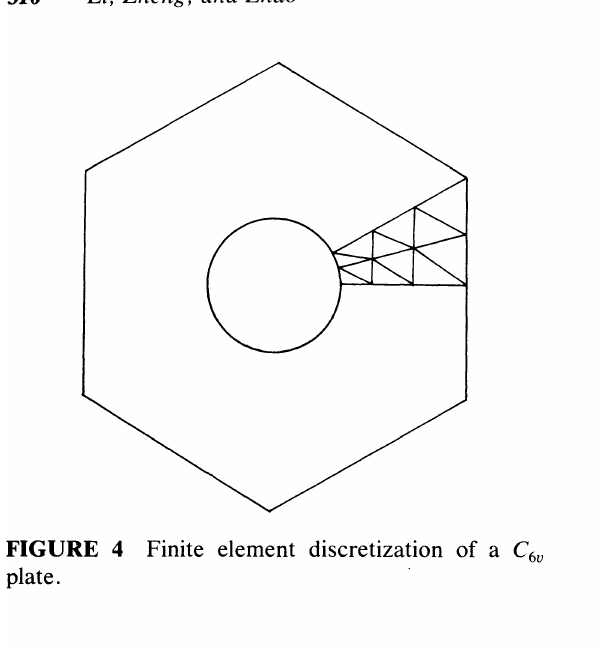
FIGURE 4 Finite element discretization of a C 6v plate.